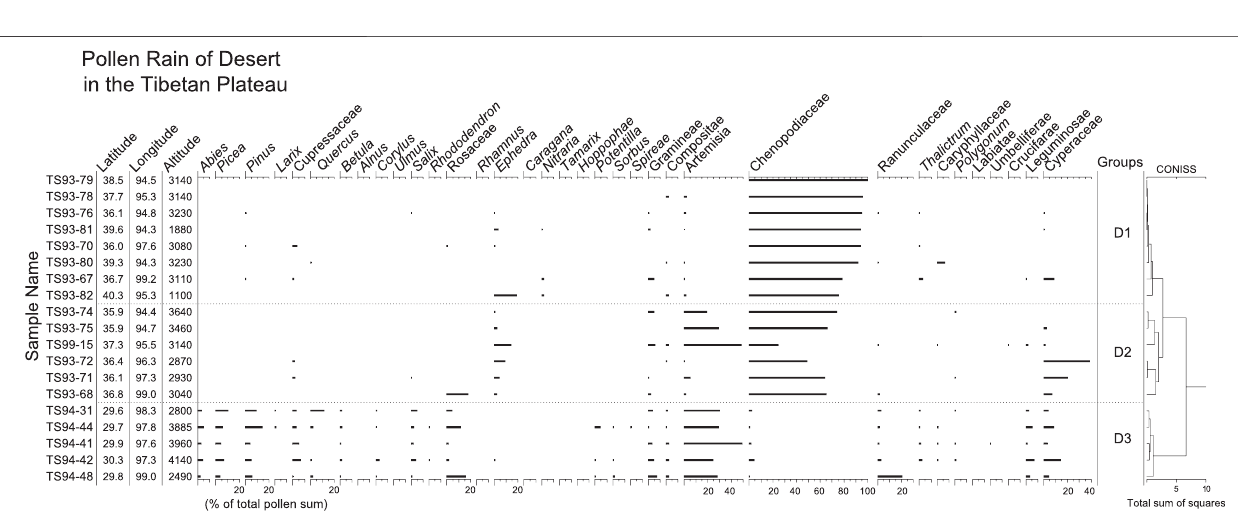
Frontiers in Earth Science |